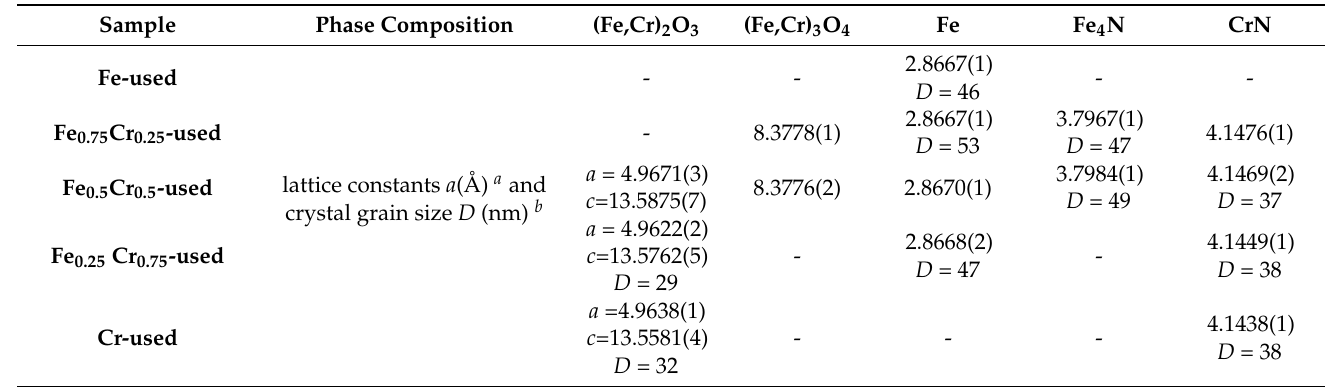
Table 3. Phase composition, lattice constants (Å), and crystal grain size ( D XRD ) of used FeCrO x catalysts.